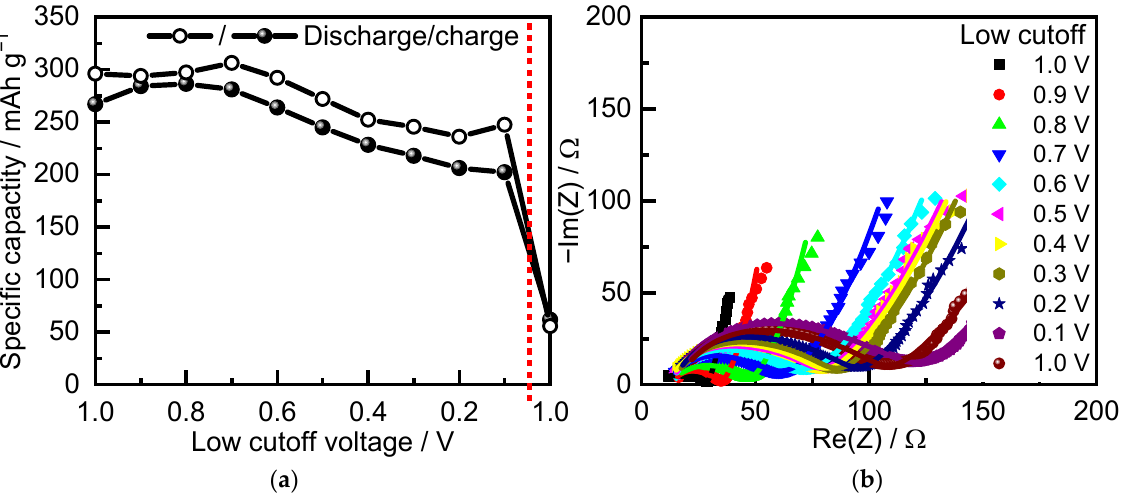
Figure 5. ( a ) Specific capacity at C/10 and ( b ) in situ impedance spectra of TNO as a function of low cutoff.